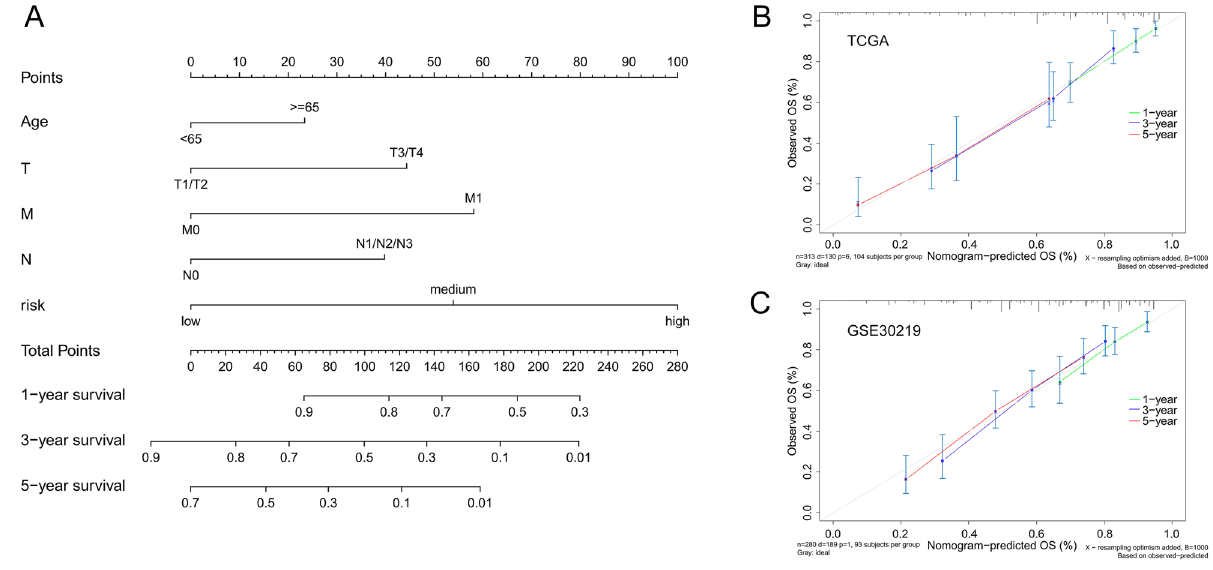
Figure 4. Construction and verification of the Nomogram using R software. ( A ) Nomogram of TCGA cohorts based on the risk groups and clinical features. ( B ) 1-, 3-, 5-year calibration curve for verification of nomogram in the TCGA cohort. ( C ) 1-, 3-, 5-year calibration curve for verification of nomogram in GSE30219.